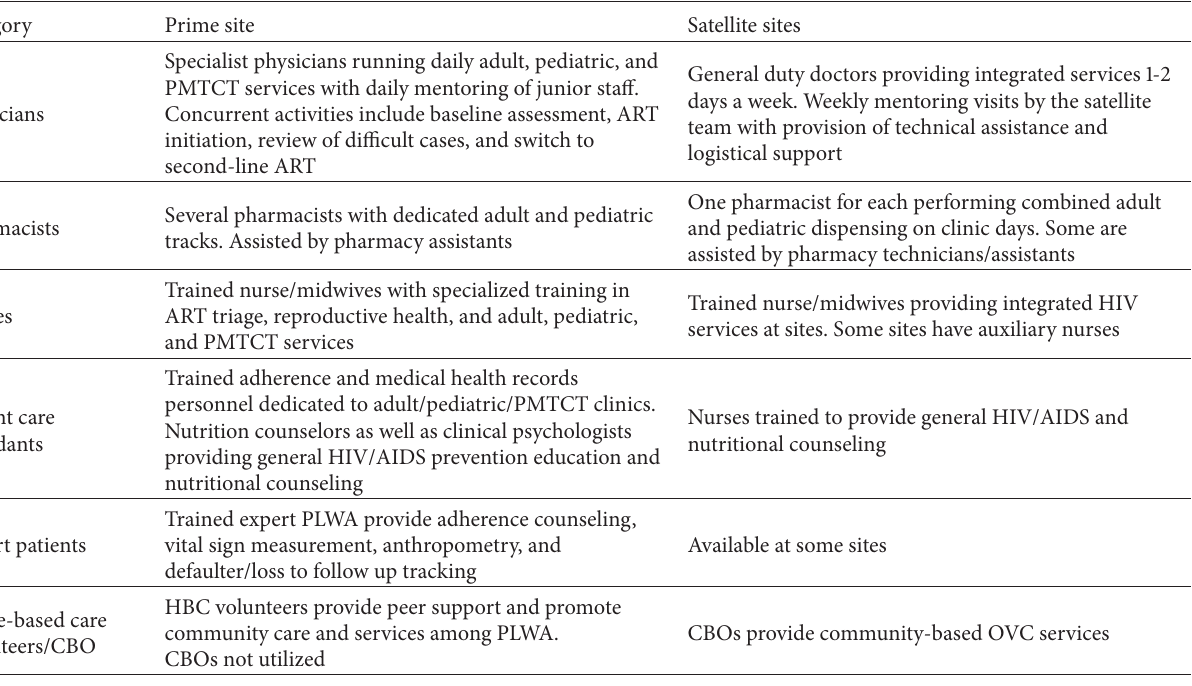
Table 1: Profile and role of health workers at the prime and satellite sites in the decentralized ART program in Jos, Nigeria. Category